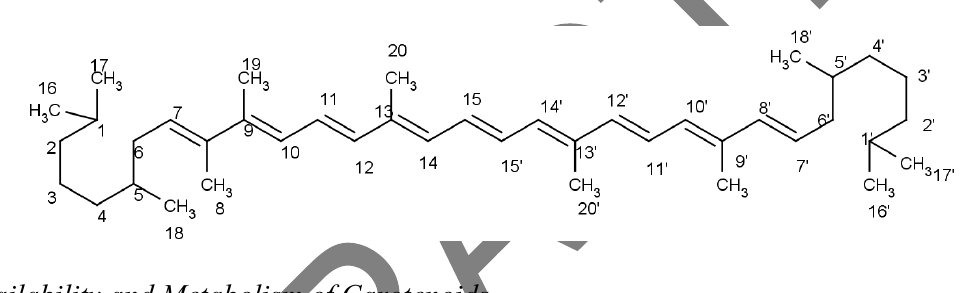
Figure1. Basic chemical structure of